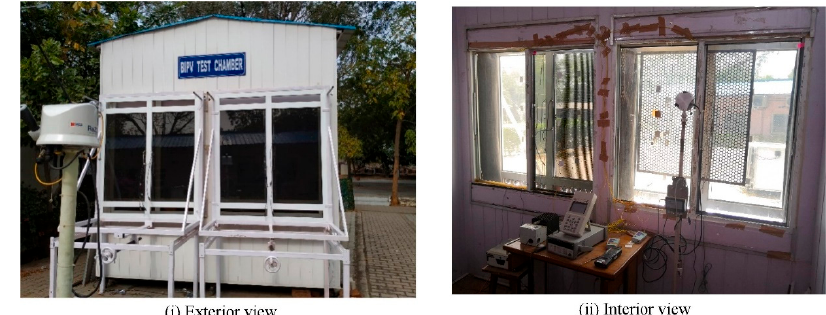
Energies 2023 , 16 , x FOR PEER REVIEW Figure 21. Inside and outside views of fenestration system proposed by Sharma et al. [63].